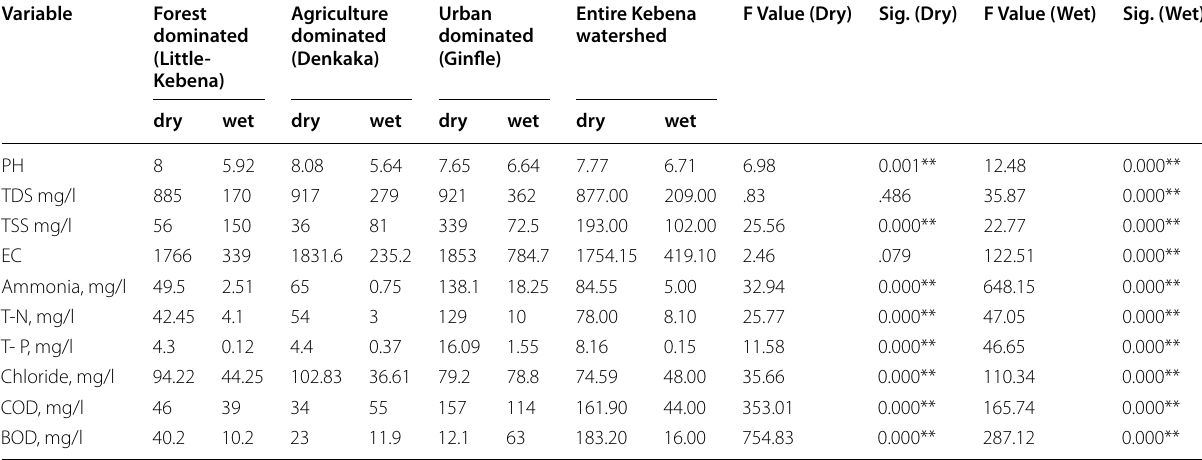
** and * Significant at1% and 5% significance level respectively